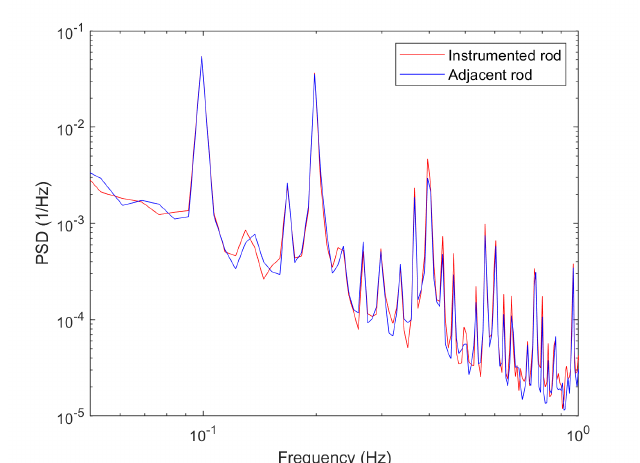
Fig. 8. Auto power spectral densities obtained with the large BGO gamma scintillator for the oscillation of the instrumented fuel rod (red), and its adjacent one (blue).